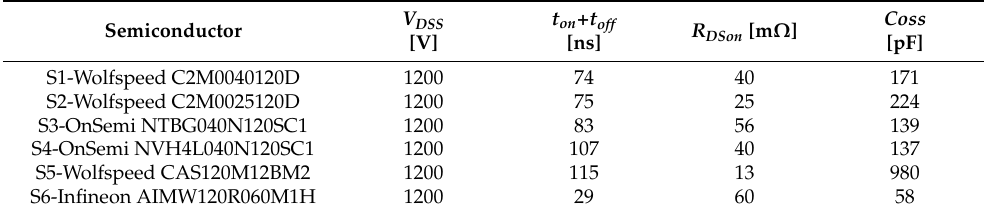
Figure 5. Relation between the SiC MOSFET turn-ON plus turn-OFF times with the channel ON- state resistance for a minimum efficiency of 99.3% at diffent values of the load resistance at constant power factor and modulation index. ( 𝑅 (cid:2868) resistance in Ω ). Table 1. List of considered semiconductors and their respective properties shown in Figure 4.